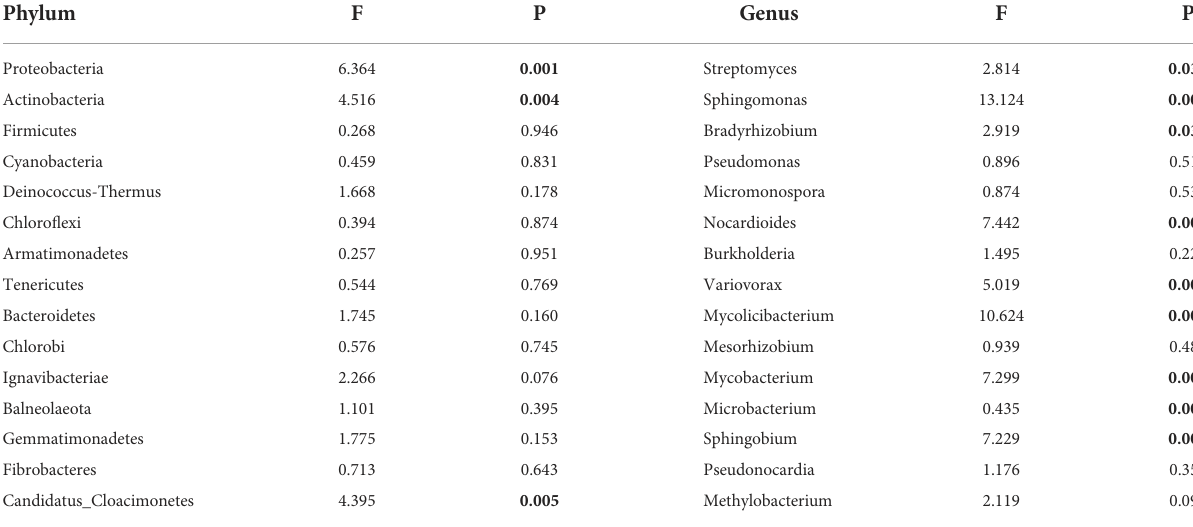
TABLE 2 Differences in community composition of phylum and genus of soil microorganisms under different water conditions. Phylum F